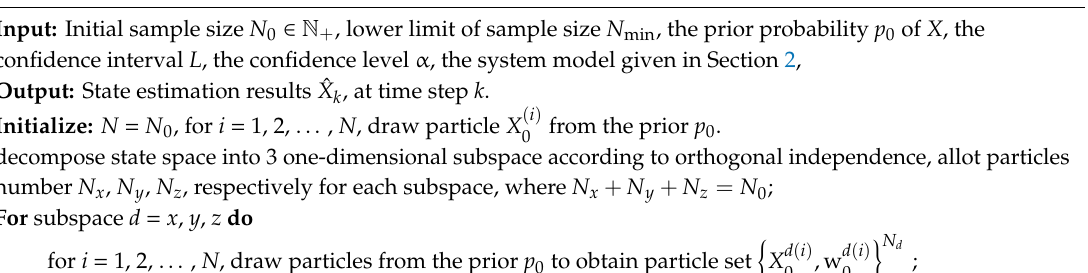
Algorithm A2. AUPF with Partitioned